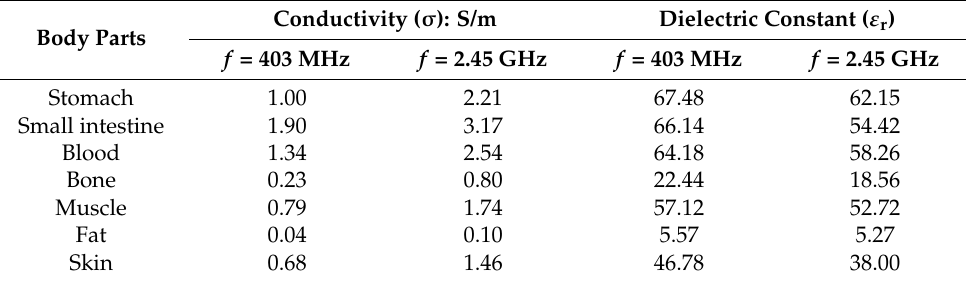
Table 3. The conductivities and dielectric constants of human organs and body parts [28]. Body Parts